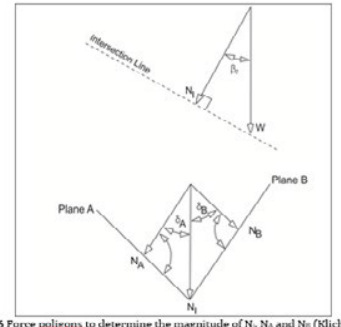
δB must be measures with stereonet or calculated as shown in Determination of force polygons to determine the magnitude of N (Figure 6). Force polygons, along with measured angles, used to determine the magnitude of Nj, NA and NB are shown in Figure 6. Then, the factor of safety can be calculated by Equation